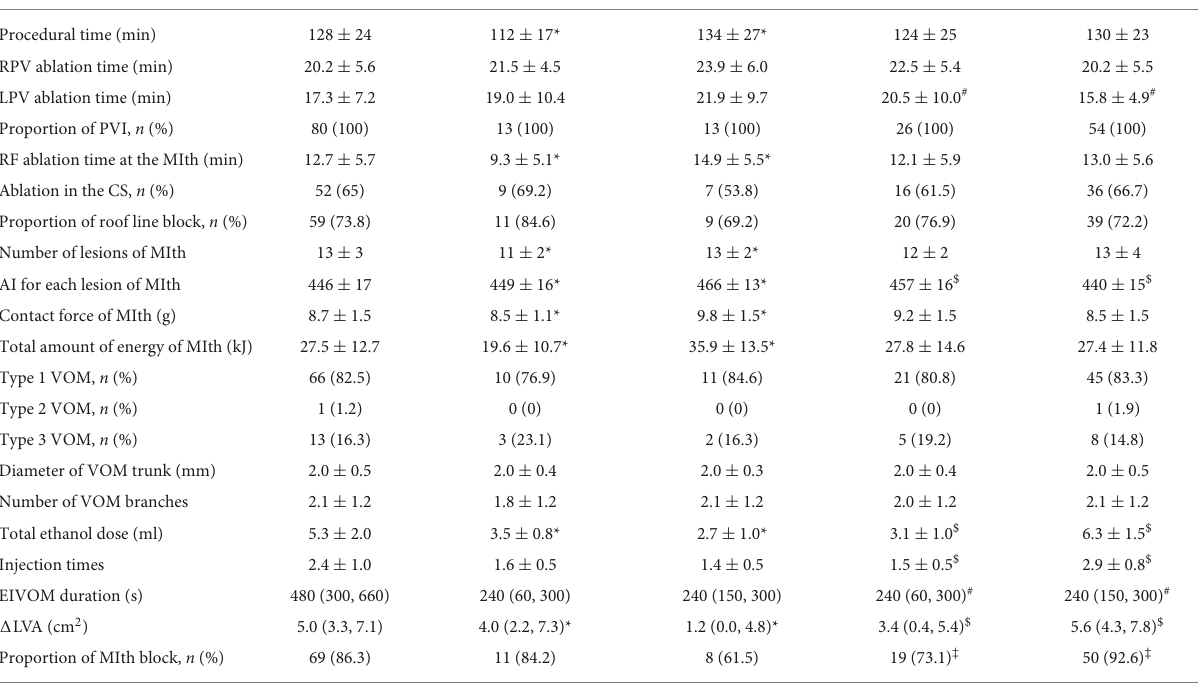
TABLE 2 Comparison of the procedural parameters between different groups. Procedural parameters